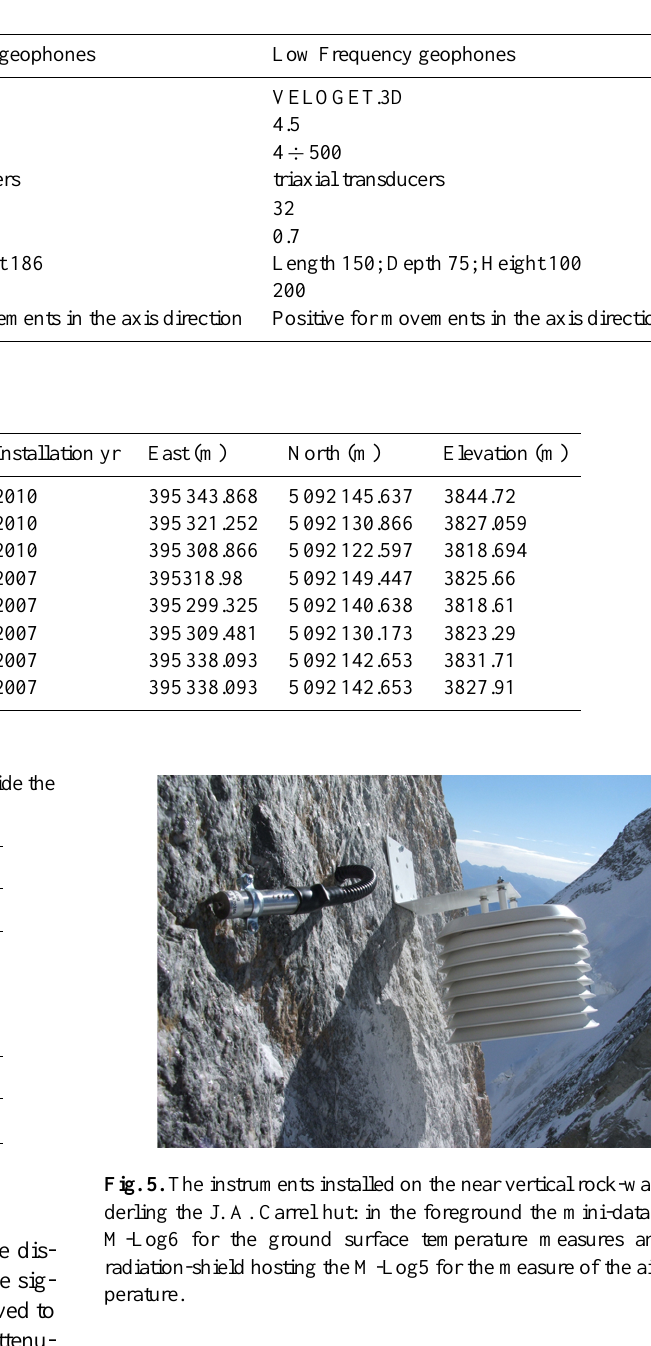
Table 1. Specifications of the installed geophones.